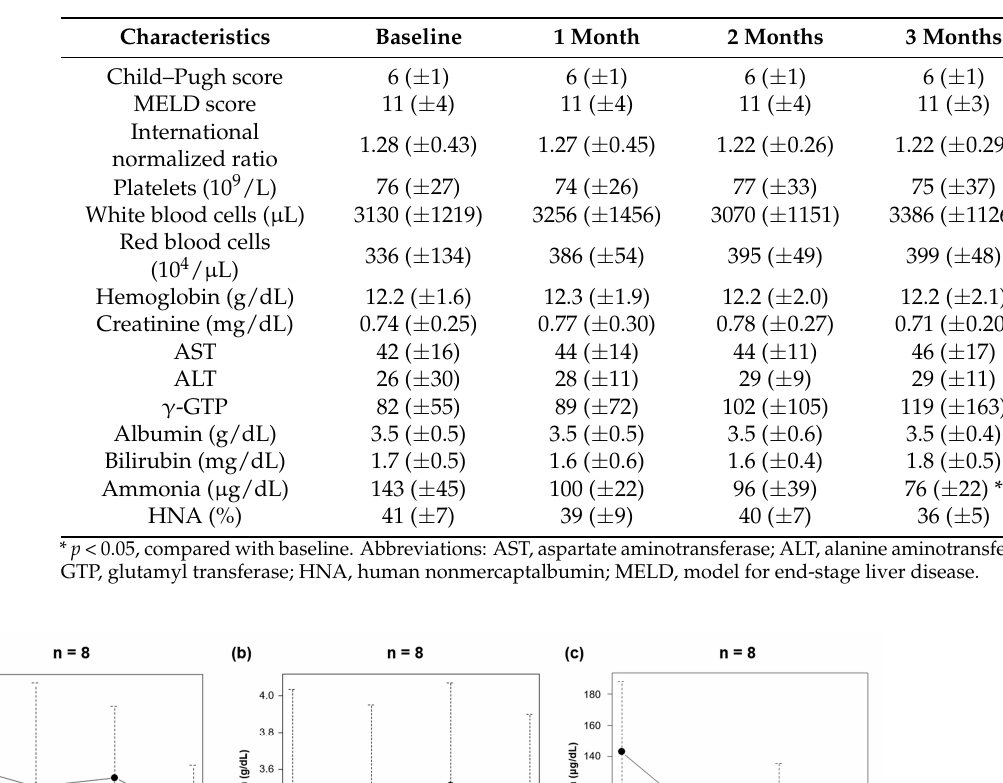
Table 1. Changes in each variable during rifaximin therapy.